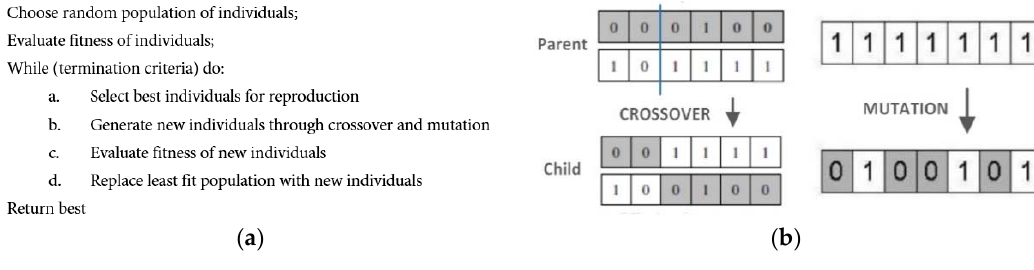
Figure 10 . ( a ) Pseudo code for genetic algorithm (GA); ( b ) crossover and mutation operations.